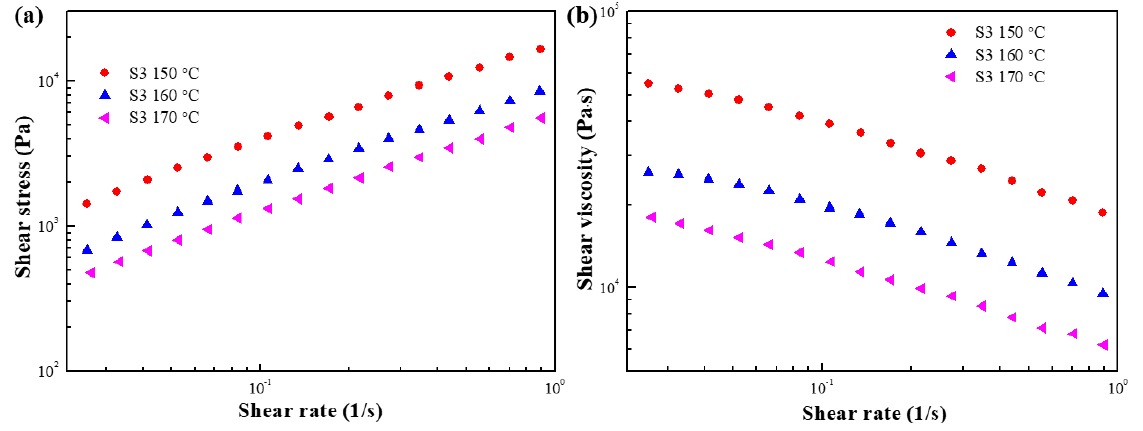
Figure 13. ( a ) Shear stress and ( b ) shear viscosity as a function of the shear rate for S3 at various temperatures.